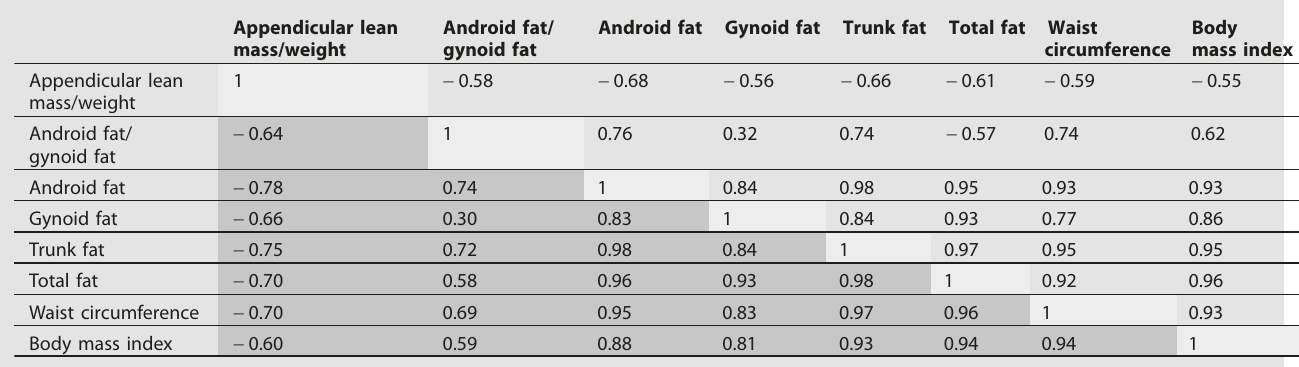
Table 2. Correlation matrix of body composition variables.